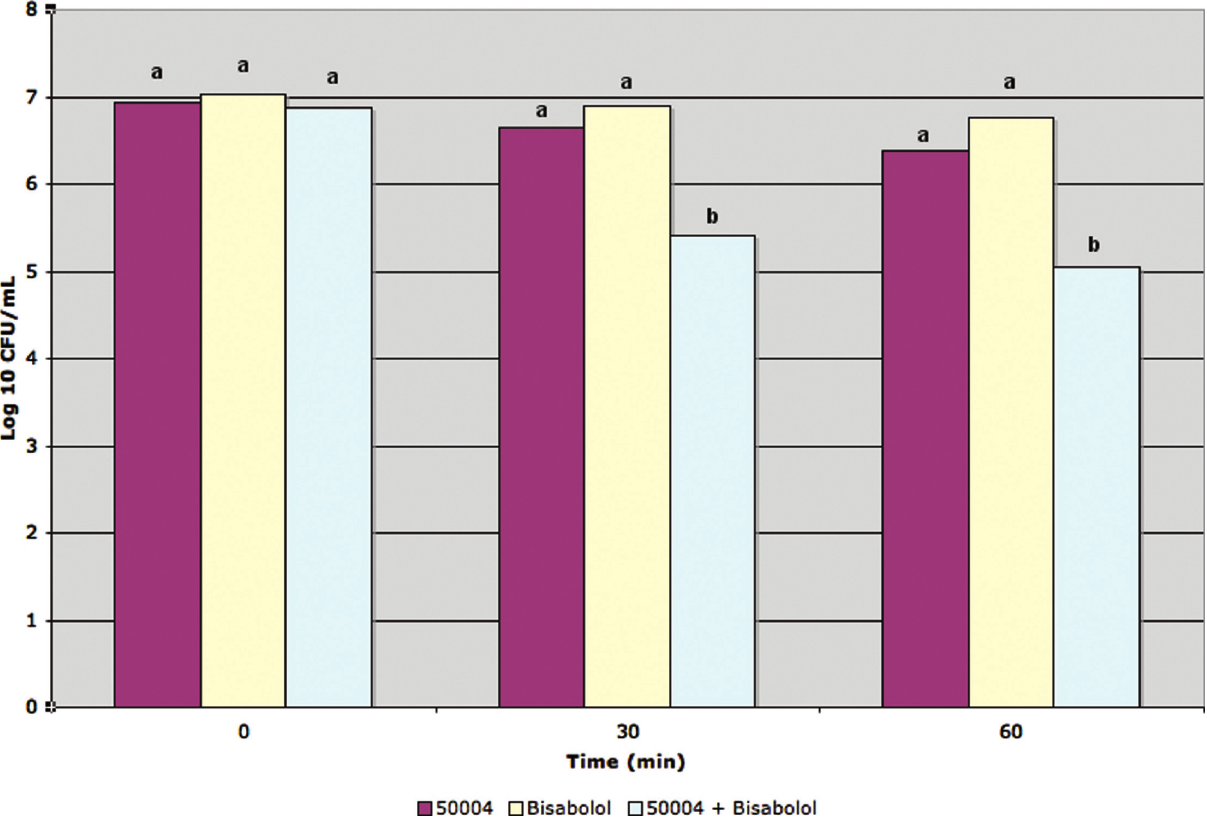
Figure 2. Enhancement of C. albicans ATCC 90028 inactivation with PMX polymer 50004. Time course kinetics with 50004 (31.25 µg/ mL) and enhancement with bisabolol (200 µM) sampled at 0, 30, and 60 min. Values for each time point having the same letter are not signi fi cantly different at p >